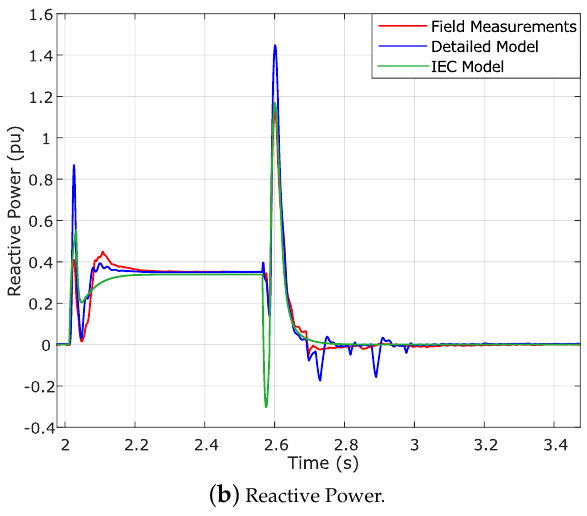
Figure 6. Active and reactive power at measurement point 2 (690 V). WT operating at full load